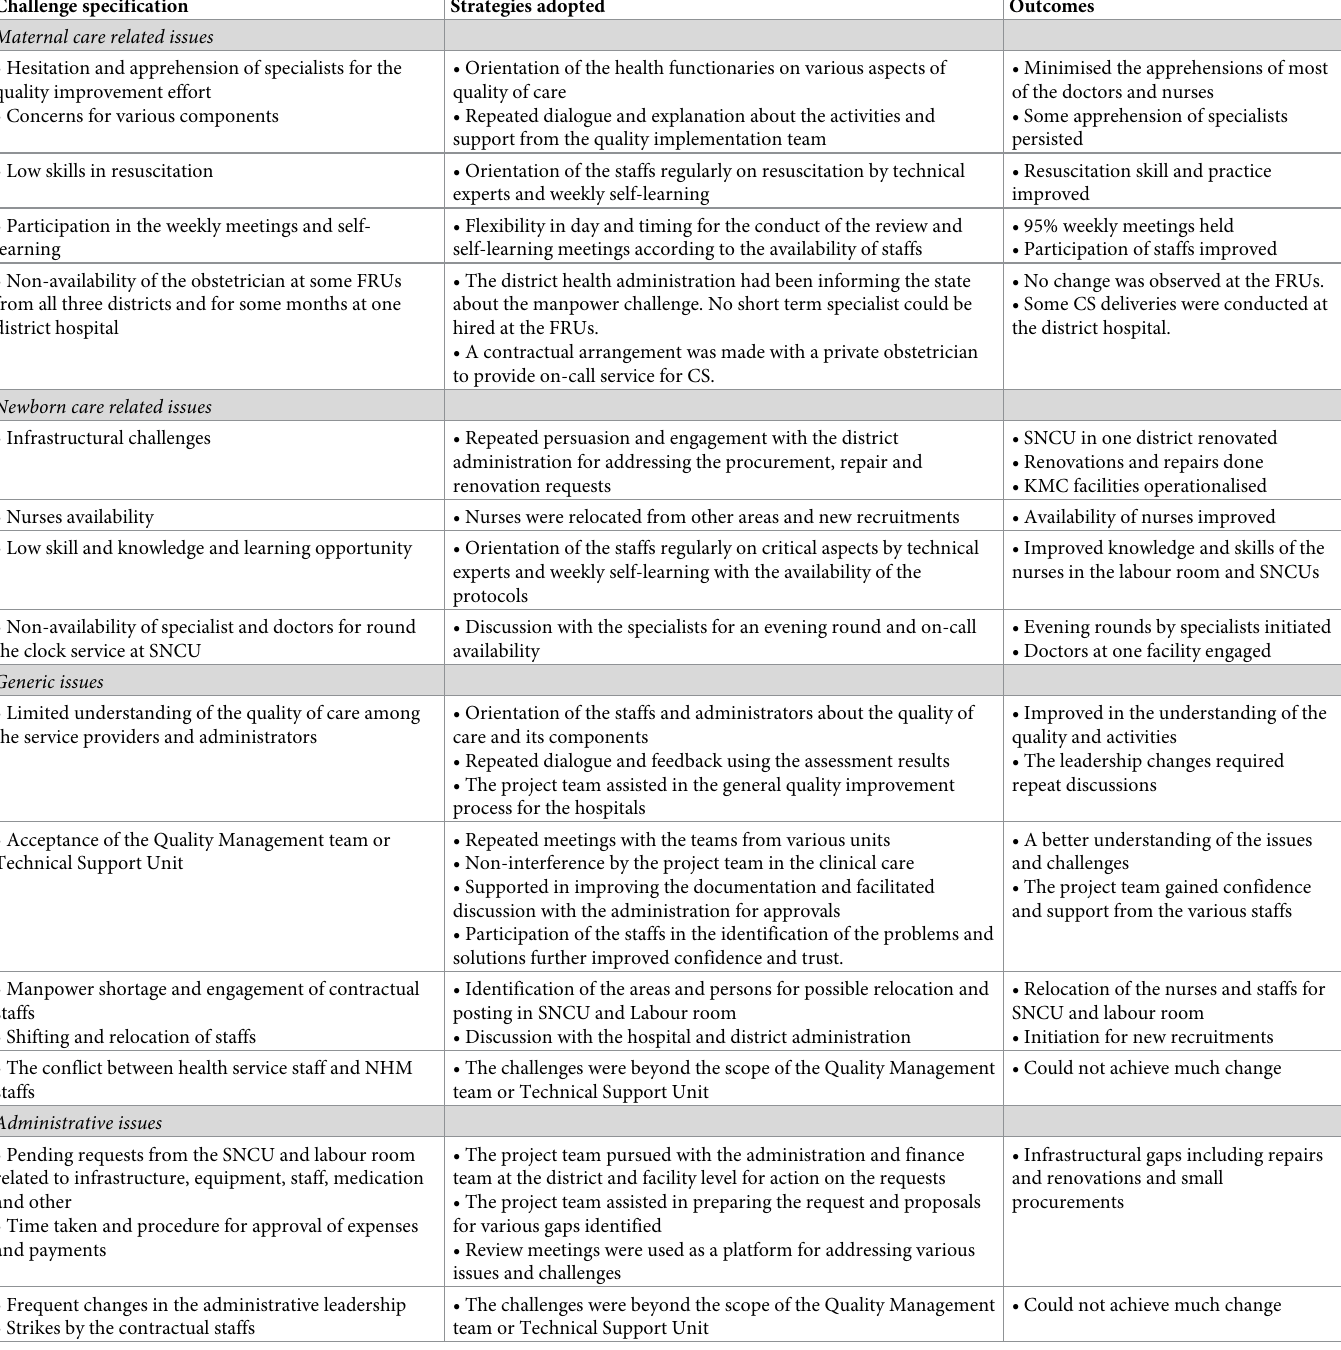
Table 4. Challenges faced, strategies adopted and outcomes achieved during the implementation of quality improvement